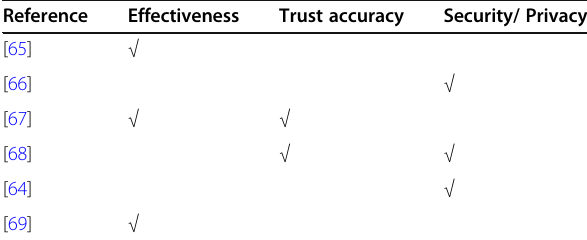
Table 2 Comparison of performance